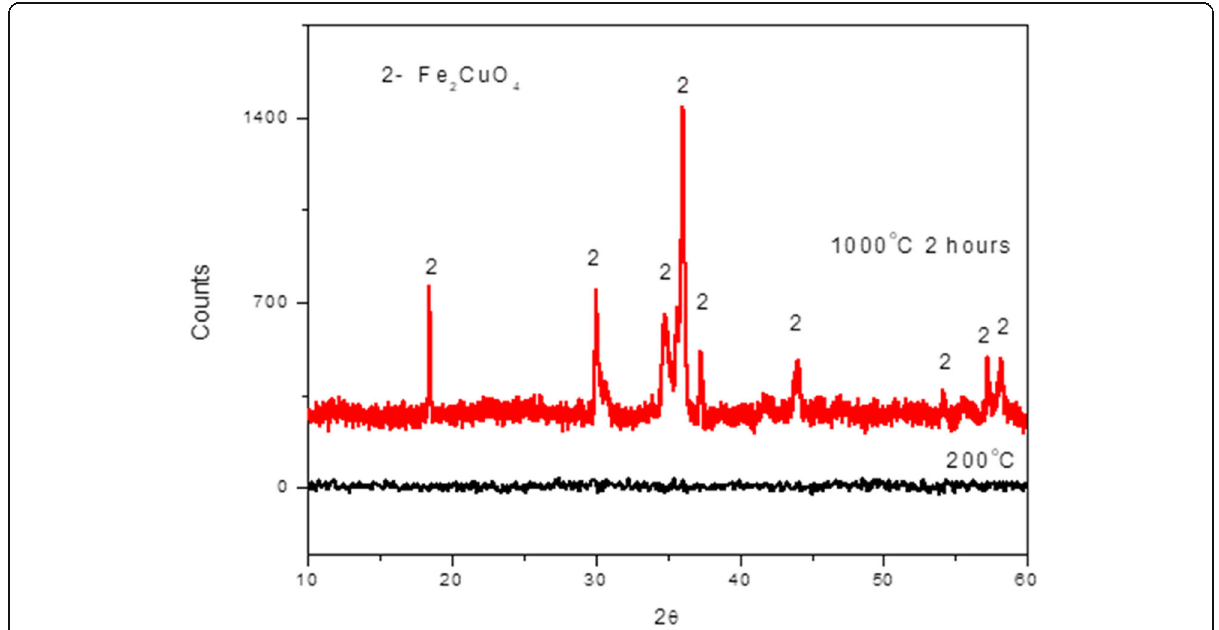
Fig. 2 XRD spectra of Cu:Fe precursors calcined at 200 °C and at 1000